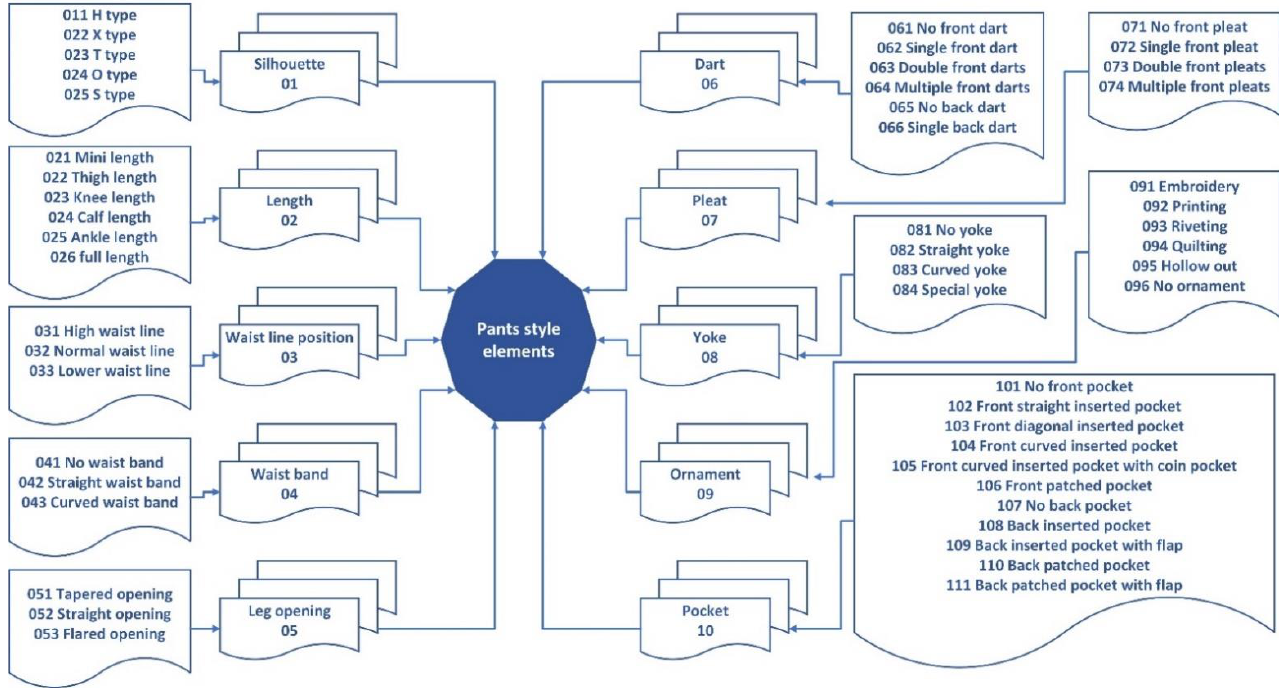
Figure 5. The classification of the pants style elements.